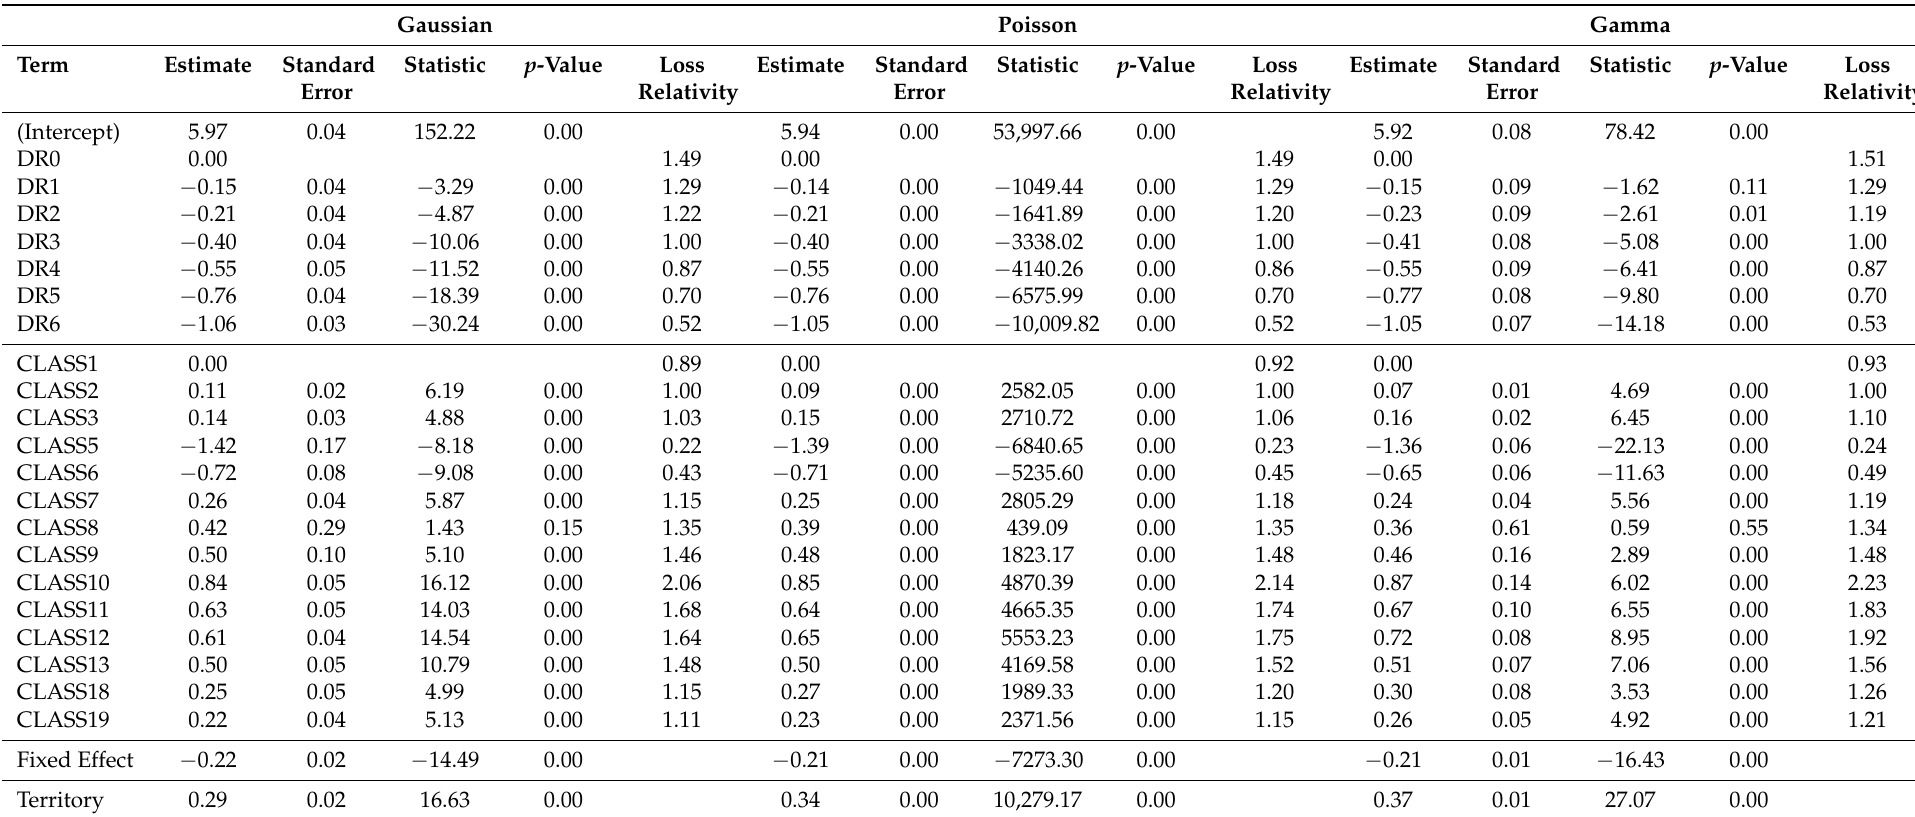
Table 4. Risk relativity estimates of DR and CLASS for TPL coverage using the combined data of three accident years under the three-way